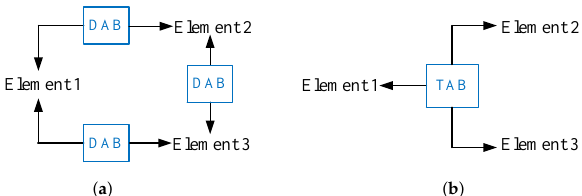
Figure 3. Comparison of a system using DAB and TAB converters. ( a ) System using DAB converter, ( b ) System using TAB